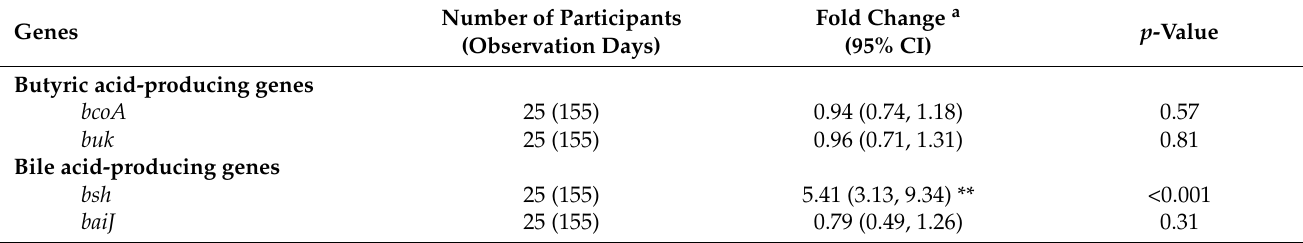
Table 3. Estimated ITT effects of probiotics on gene copy numbers, based on linear mixed-effects models adjusted by gestational age. ** indicates p <